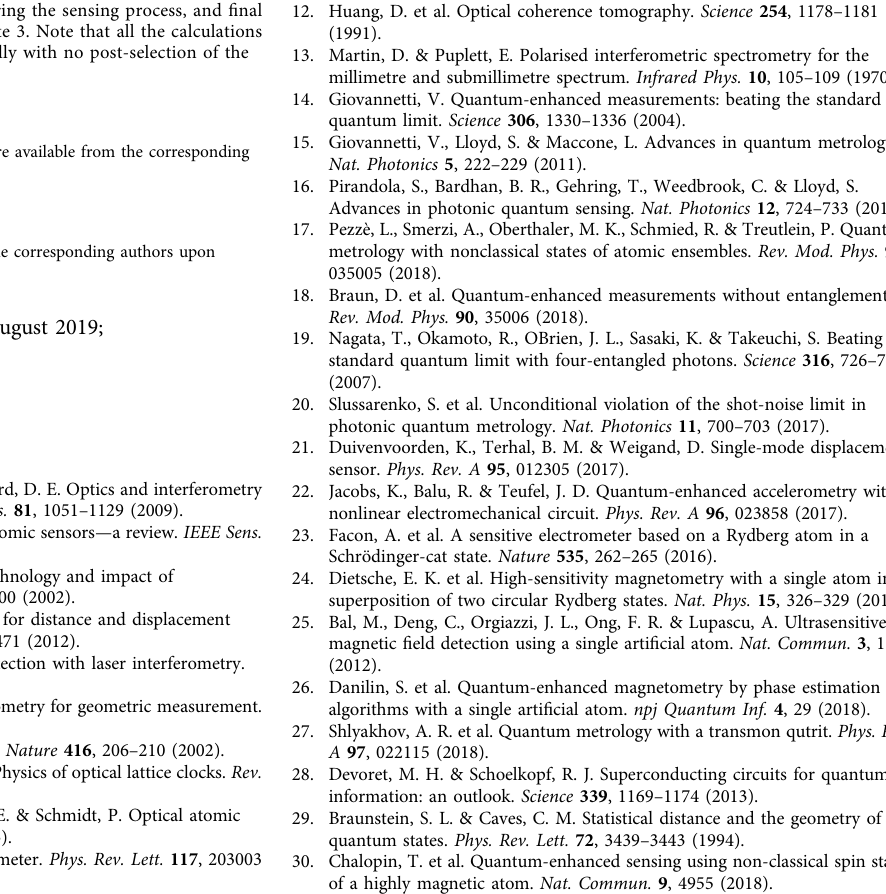
numerical simulations further provide valuable information on the contribution of each imperfection to the loss of measurement precision. The detailed analysis of the errors in the three stages of the quantum metrology experiment: initial state preparation, evolution of the system during the sensing process, and fi nal detection are described in Supplementary Note 3. Note that all the calculations and experiments are performed unconditionally with no post-selection of the experimental and numerical outcomes.